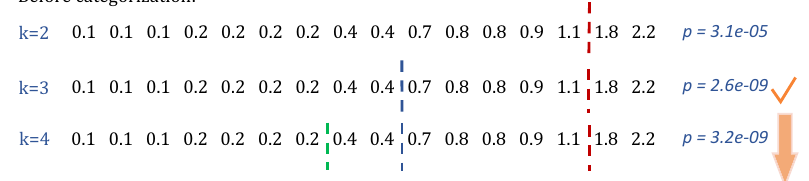
Figure 3. Overview of AMC